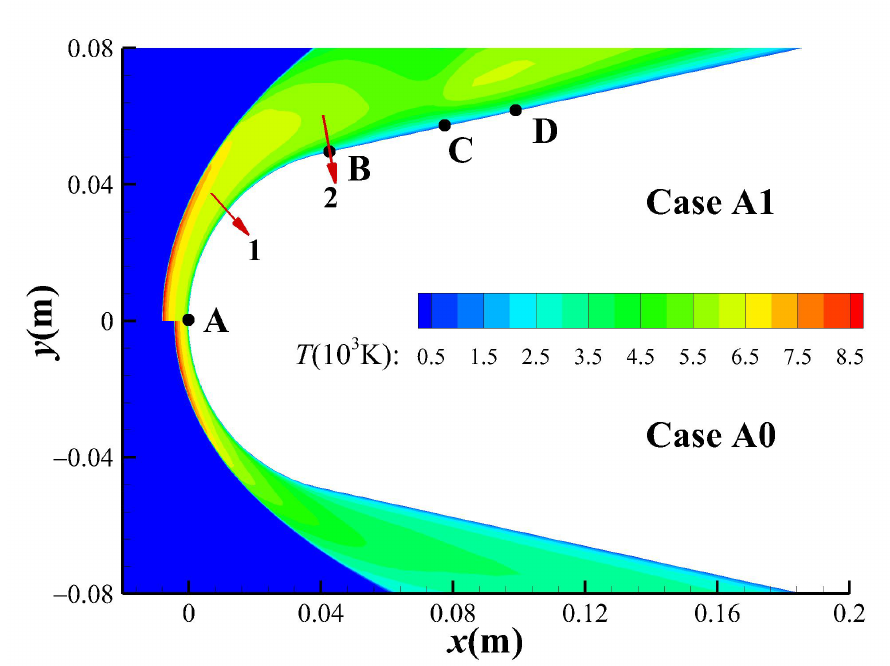
Figure 10. Comparison of flow field with and without external magnetic